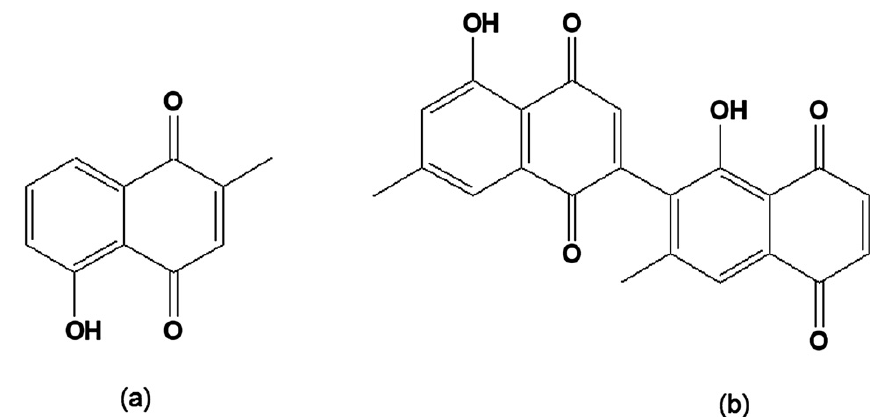
Figure 6. (a) 5-Hydroxy-2-methyl-1,4-naphthoquinone [plumbagin]; (b) [1´,5-Dihydroxy-